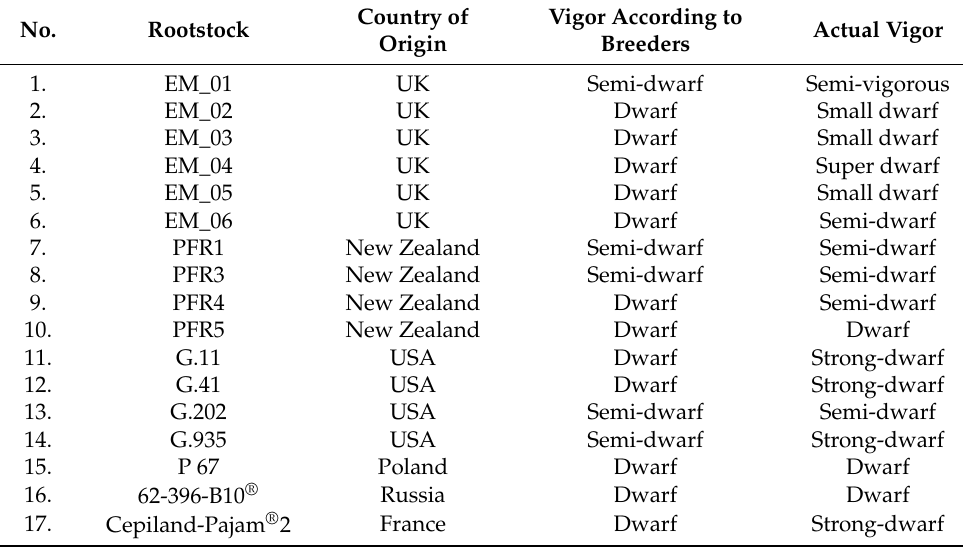
Table 1. Origin and growth characteristics of apple